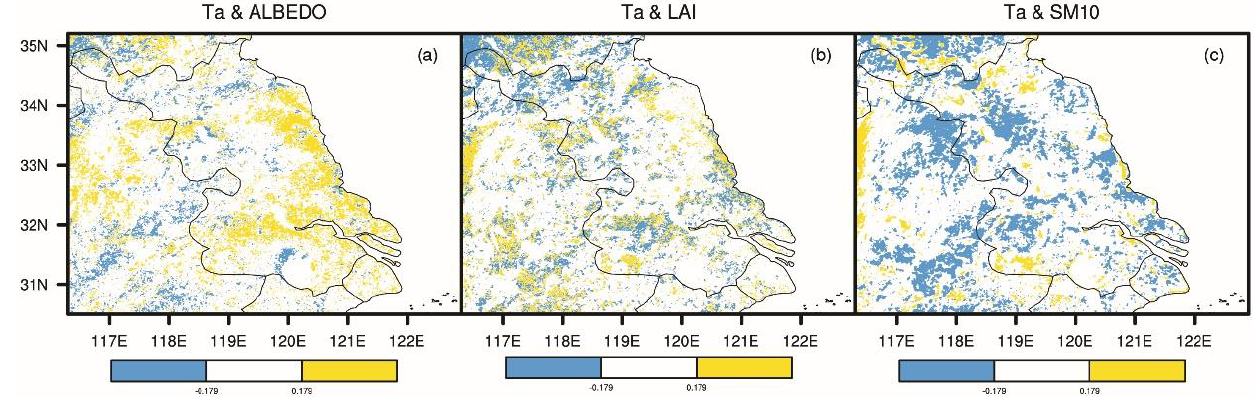
Figure 12. Spatial distribution of correlation coefficient (r) between ( a ) air-temperature and albedo difference, ( b ) LAI difference, and ( c ) 10 cm soil water difference over the research period in EC.